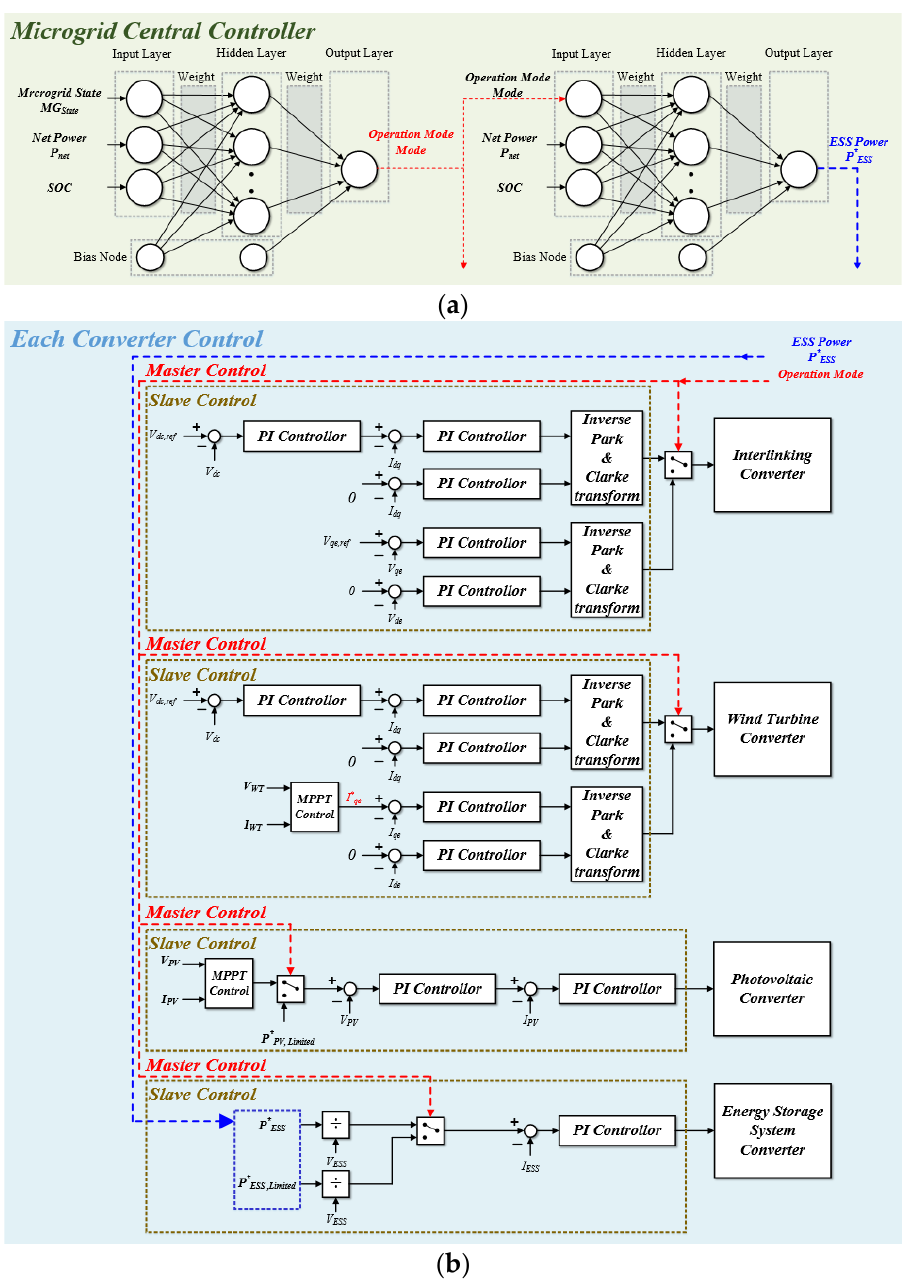
Figure 4. Microgrid control configuration based on ANN. ( a ) Structure of MGCC with proposed two-step ANN for EMS. ( b ) Structure of whole converter control block diagram.